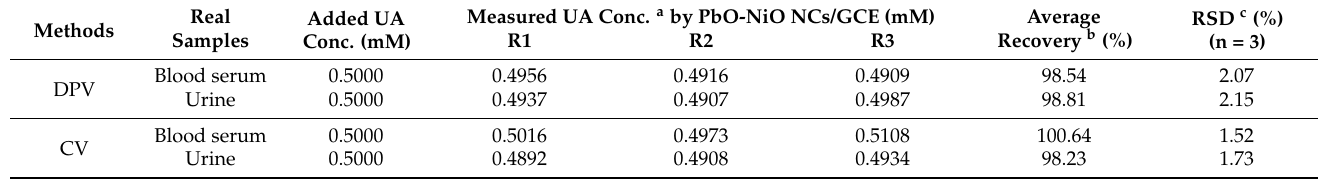
Table 2. Analyses of real samples with PbO-doped NiO NCs/GCE probe